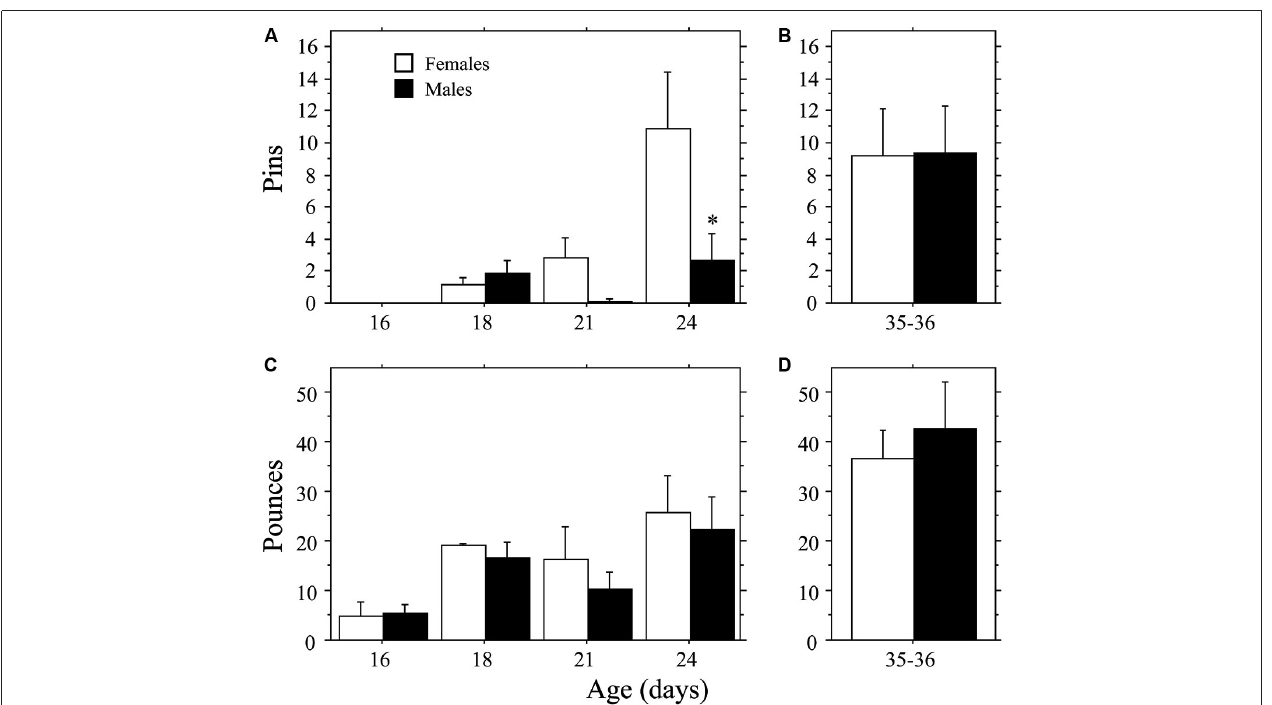
FIGURE 1 | Development of play behavior in female and male age-matched rat pairs . Mean number (+s.e.m.) of pins (A and B) and pounces (C and D) per playmate in weanling ( A and C ; Experiment 1a) and juvenile ( B and D ; Experiment 1b) play pairs; * indicates significant sex difference within age